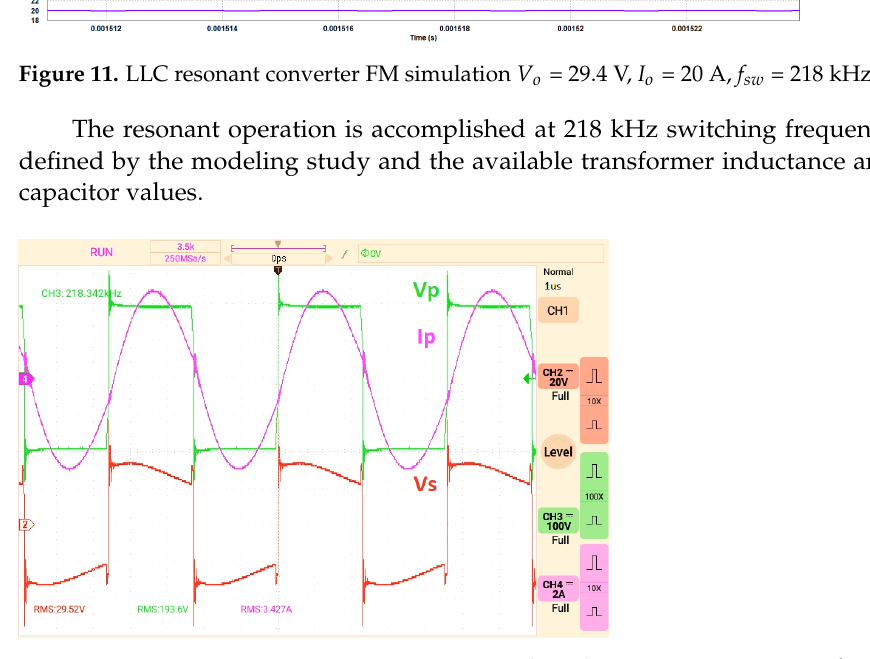
Figure 12. LLC resonant converter FM experimental results V o = 29.4 V, I o = 20 A, f sw = 218 kHz. The voltage and current of the transformer primary and the battery voltage and current are given in Figure 13 for the simulation study of a 3 A charging current, which indicates partial loading at 270 kHz switching frequency. Figure 14 shows the experimental measurements of the voltage and current of the transformer primary and the battery voltage and current for the 3 A charging current at 270 kHz switching frequency.